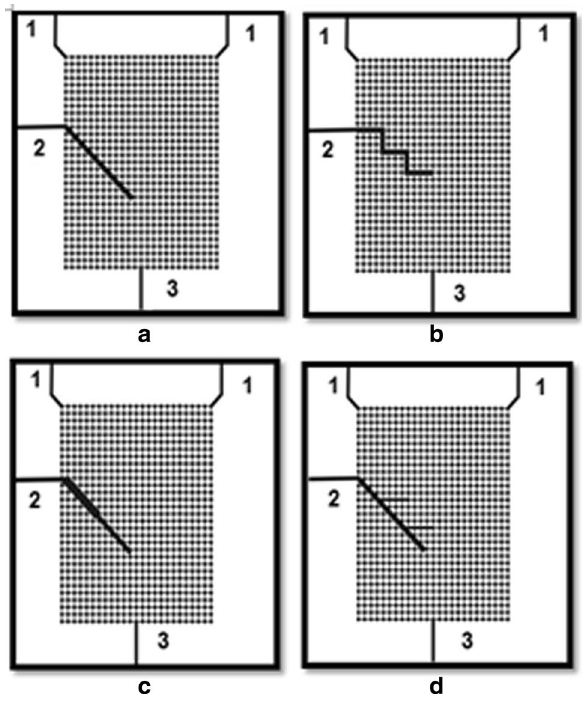
Fig. 3 Different micromodel patterns; a a simple fracture, b a stepped fracture, c a fracture with variable mouth, d a fracture with a tiny crack. *Numbers 1–3 indicate the water inlets, PPG inlet and the out- let, respectively Table 1 The properties of the micromodels Property Value